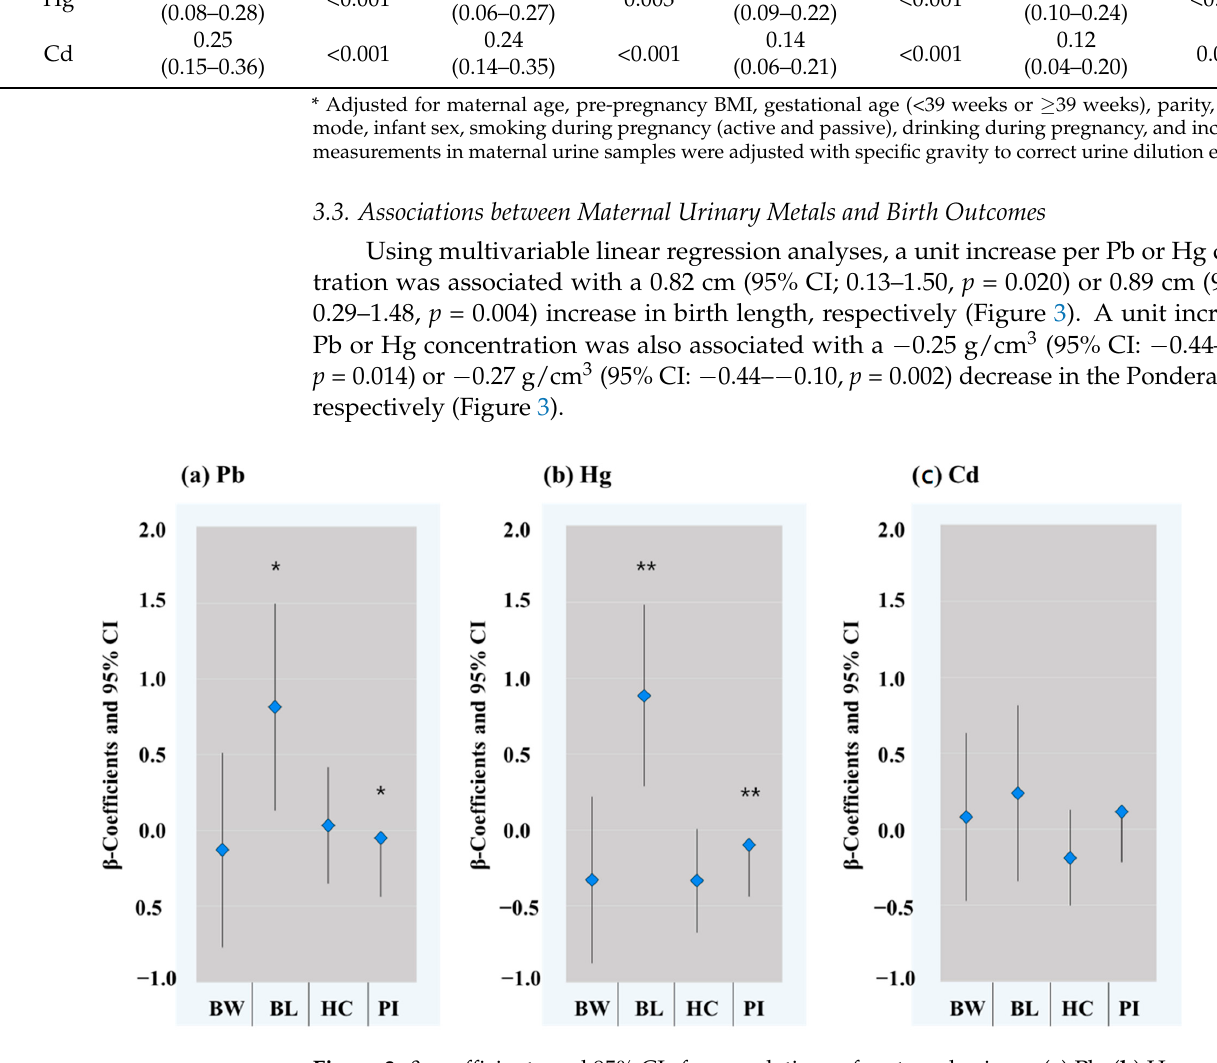
Figure 3. β -coefficients and 95% CIs for correlations of maternal urinary ( a ) Pb, ( b ) Hg, and ( c ) Cd levels with birth weight, birth length, head circumference, and Ponderal index after adjusting for maternal age, pre-pregnancy BMI group, gestational age (<39 weeks or ≥ 39 weeks), parity, delivery mode, infant sex, smoking during pregnancy (active and passive), drinking during pregnancy, and income. Pb, Cd, and Hg levels in maternal urine samples were adjusted using urine specific gravity. Birth weight was divided by 100 to fit the scale of the figure. * p < 0.05, ** p < 0.01. BW: birth weight; BL: birth length; HC: head circumference; PI: Ponderal index.